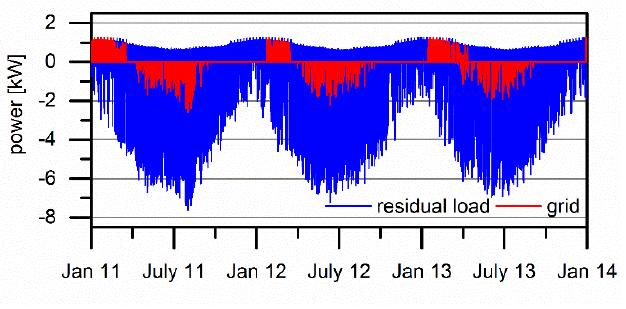
Figure 14. Comparison of residual load and grid exchange